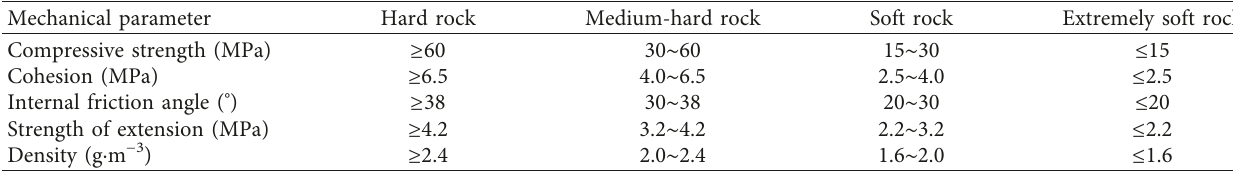
Table 1: Mechanical parameters of the floor.